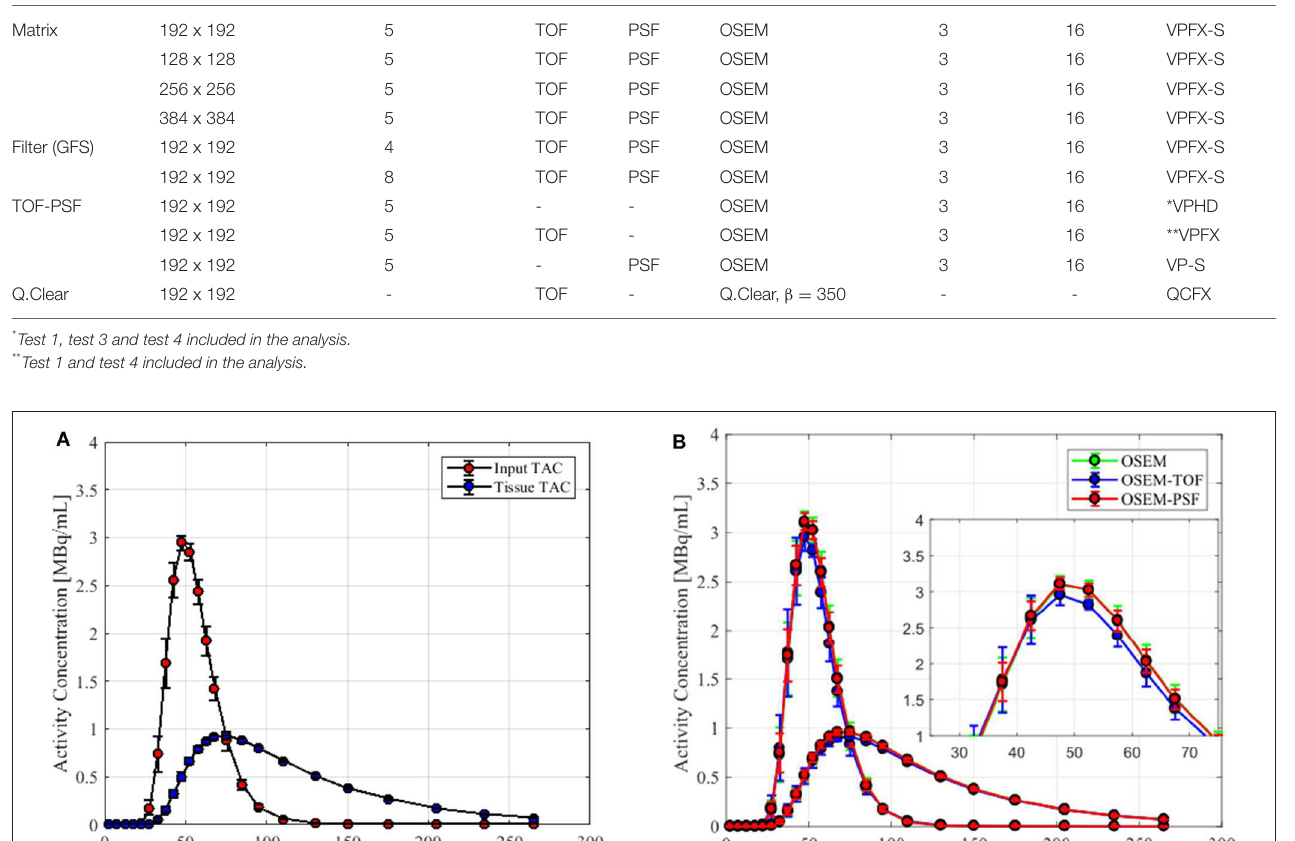
TABLE 2 | Reconstruction parameters applied in the flow phantom study, separated according to matrix and filter (GFS) size, TOF and PSF and regularized Q.Clear reconstruction. Matrix size Algorithm